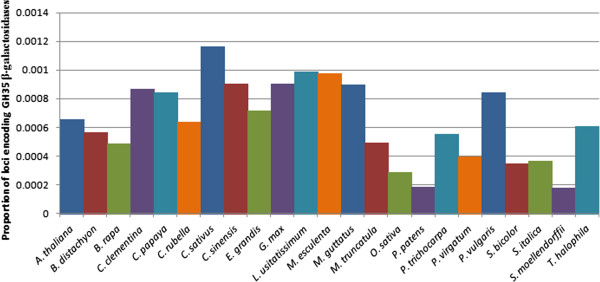
Relative quantity of BGAL genes in the genomes of various plant species. Predicted proteomes for Arabidopsis thaliana, Brachypodium distachyon, Brassica rapa, Citrus clementina, Carica papaya, Capsella rubella, Cucumis sativus, Citrus sinensis, Eucalyptus grandis, Glycine max, Linum usitatissimum, Manihot esculenta, Mimulus guttatus, Medicago truncatula, Oriza sativa, Physcomitrella patens, Populus trichocarpa, Panicum virgatum, Phaseolus vulgaris, Sorghum bicolor, Setaria italica, Selaginella moellendorffii, and Thellungiella halophila were obtained from Phytozome (version 8.0) [14]. Sequences were assessed via Hidden Markov Model (HMM) with HMMER3 [15], using the Pfam-A family database (version 25.0) [17], for genes putatively encoding a glycosyl hydrolase 35 domain. The number of putative BGAL genes was compared to the total number of protein coding loci published for each species at Phytozome (version 8.0) [14].